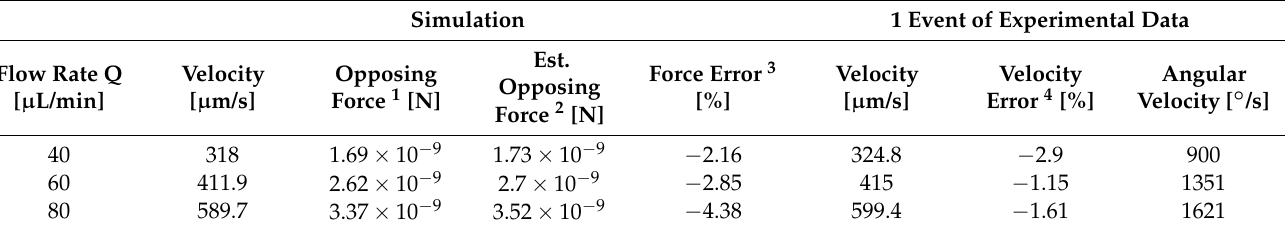
Table 3. Simulated velocities with opposing force vs. experimental